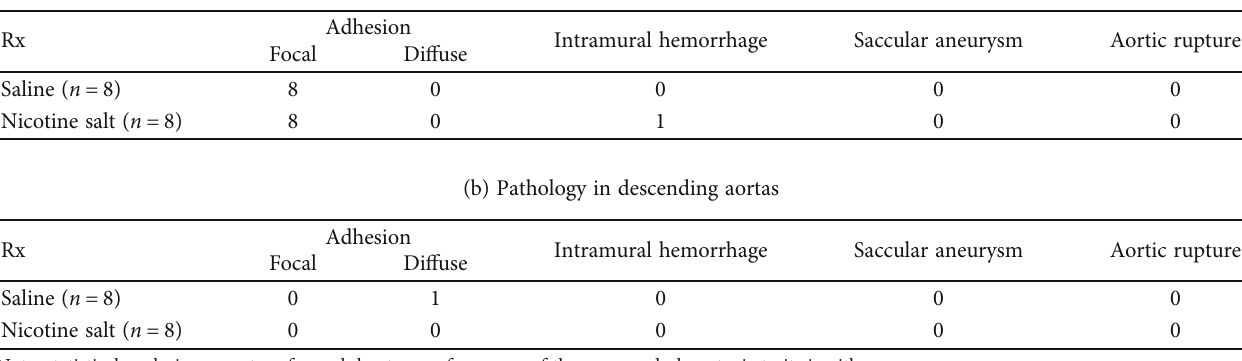
Table 2: Gross pathology detected in mice receiving nicotine pellets (5.0 mg NFB, 90-day release).